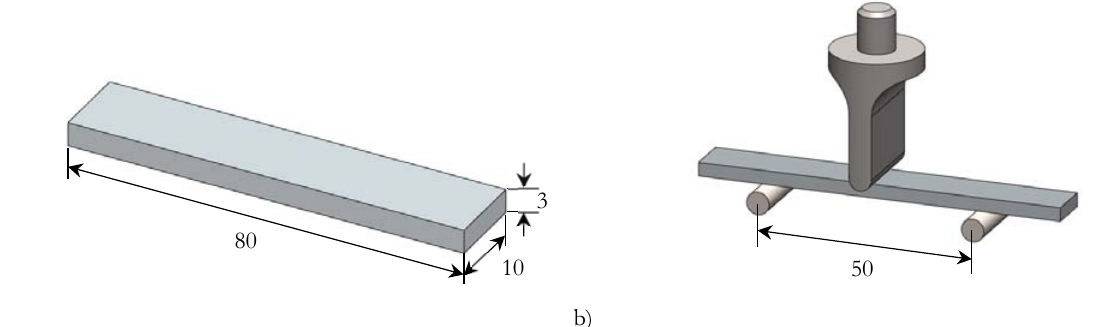
Figure 3: a) Geometry of the specimens; b) Three-point bending apparatus. All dimensions in